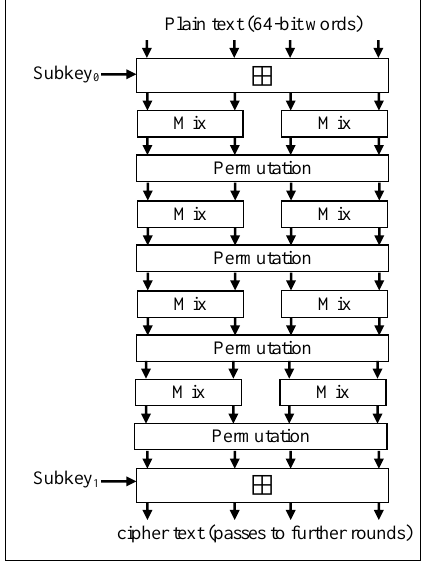
Figure 1. Four rounds of Threefish256 encryption [7]